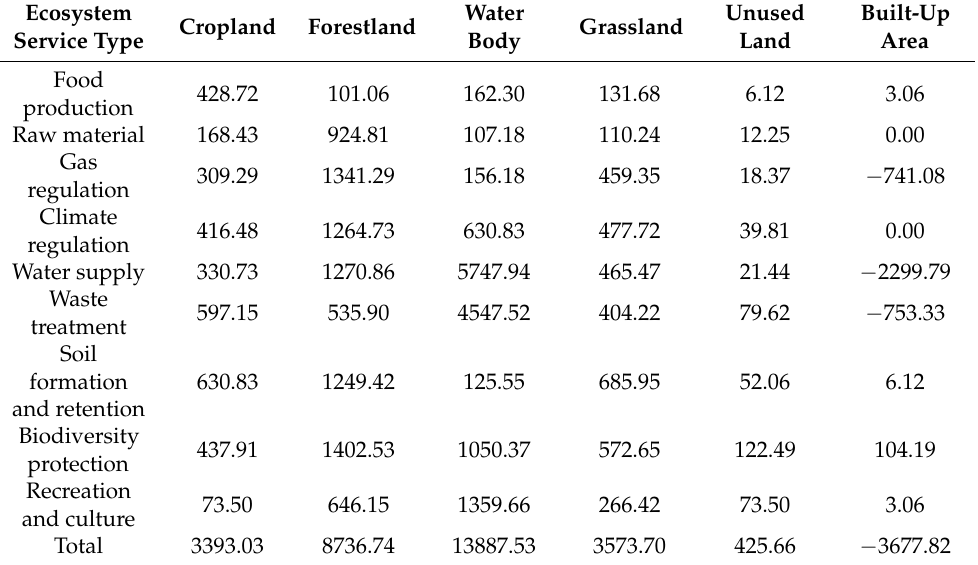
Table 3. Locally adapted per-unit ecosystem service value for Guangdong in 2018 US$ ha − 1